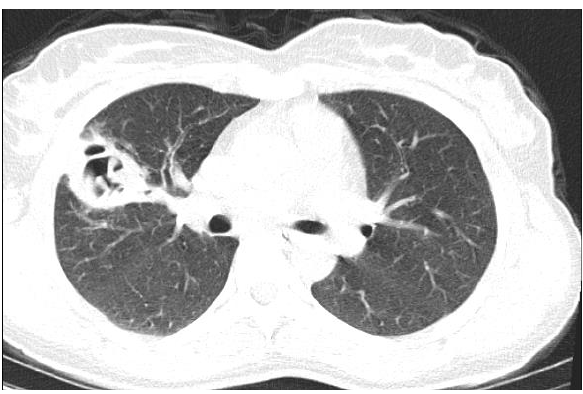
Figure 1. Spiral lung HRCT showing mass with cavity.